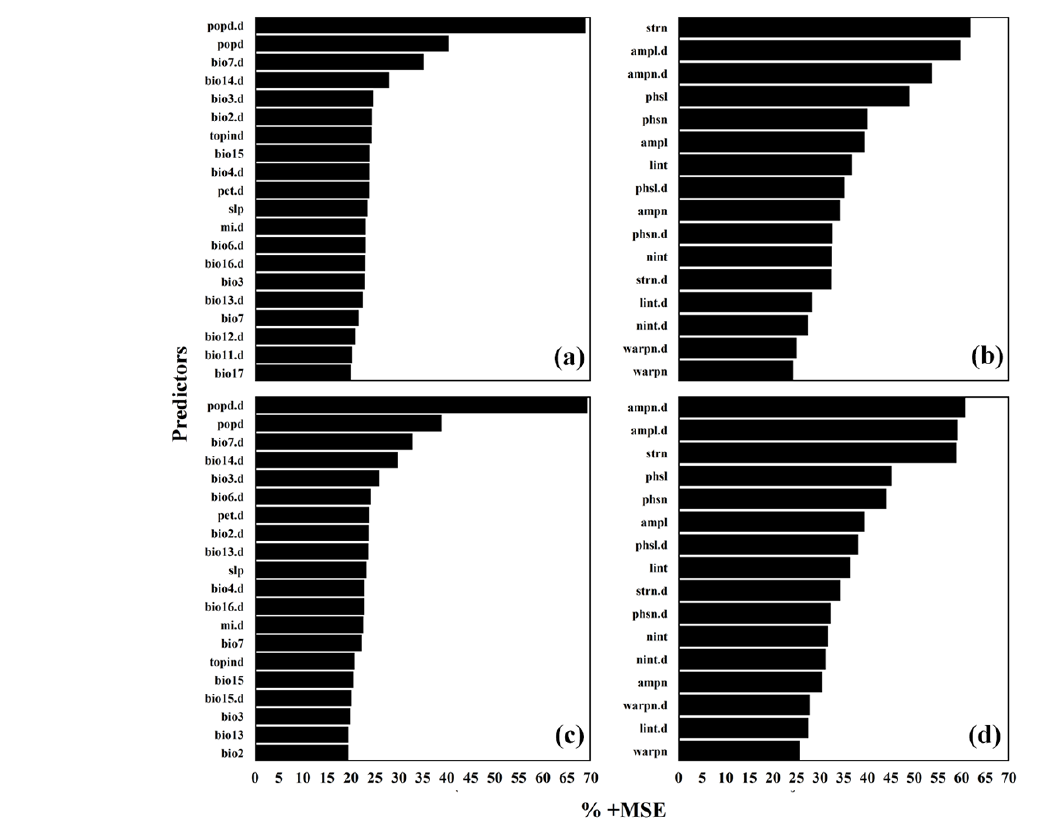
Figure 4. Percent mean squared error (MSE) increase after each of the top 20 non-remote-sensing (a, c) and 16 remote sensing (b, d) predic- tors were omitted from the random forest ensemble model predicting the proportion of agriculture and natural vegetation in the calibration sample frames, respectively. The models explained 69, 49, 69, and 50% of the proportion